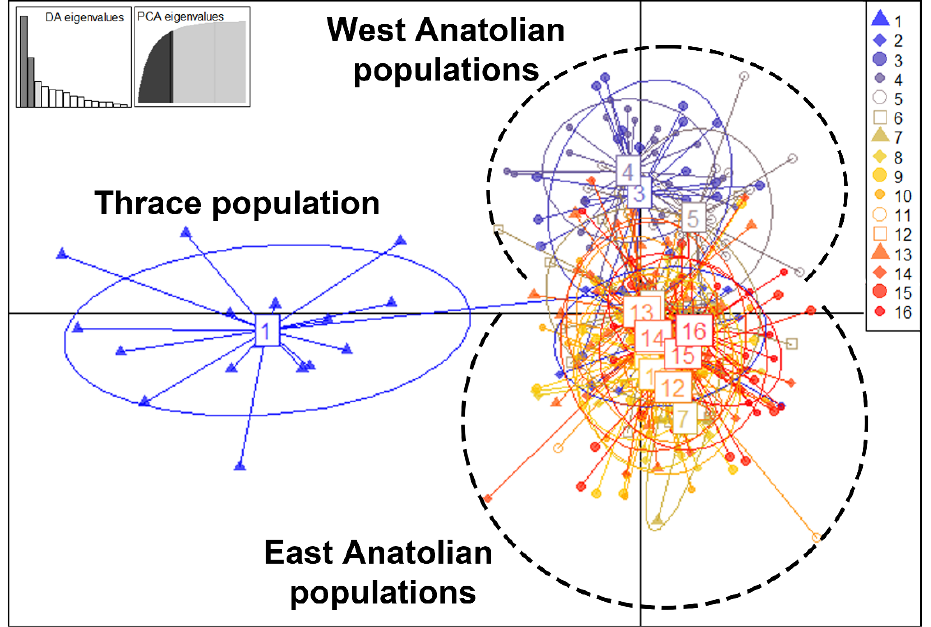
Figure 4. Discriminant analysis of principal components (DAPC) results based on 13 microsatellite loci studied among 347 individuals from 16 A. chukar populations. loci studied among 347 individuals from 16 A. chukar